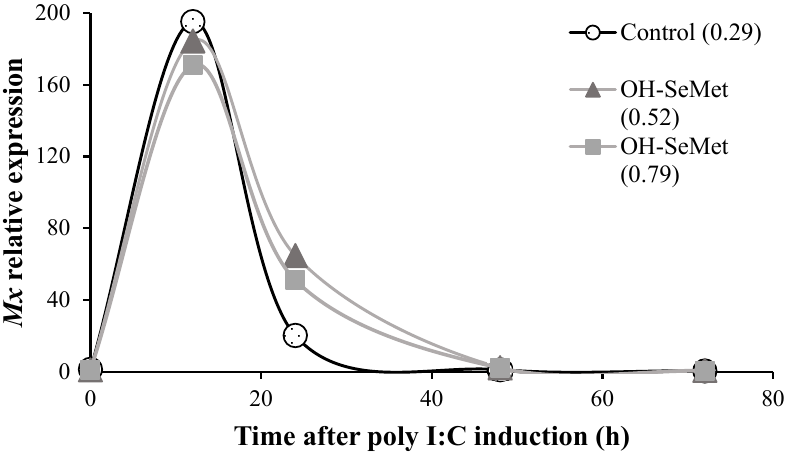
Figure 3. Relative expression of Mx (fold changes in relation to the values at 0 h for each diet) in liver of gilthead seabream fed diets with different supplementation of OH-SeMet along the anti-viral response challenge.